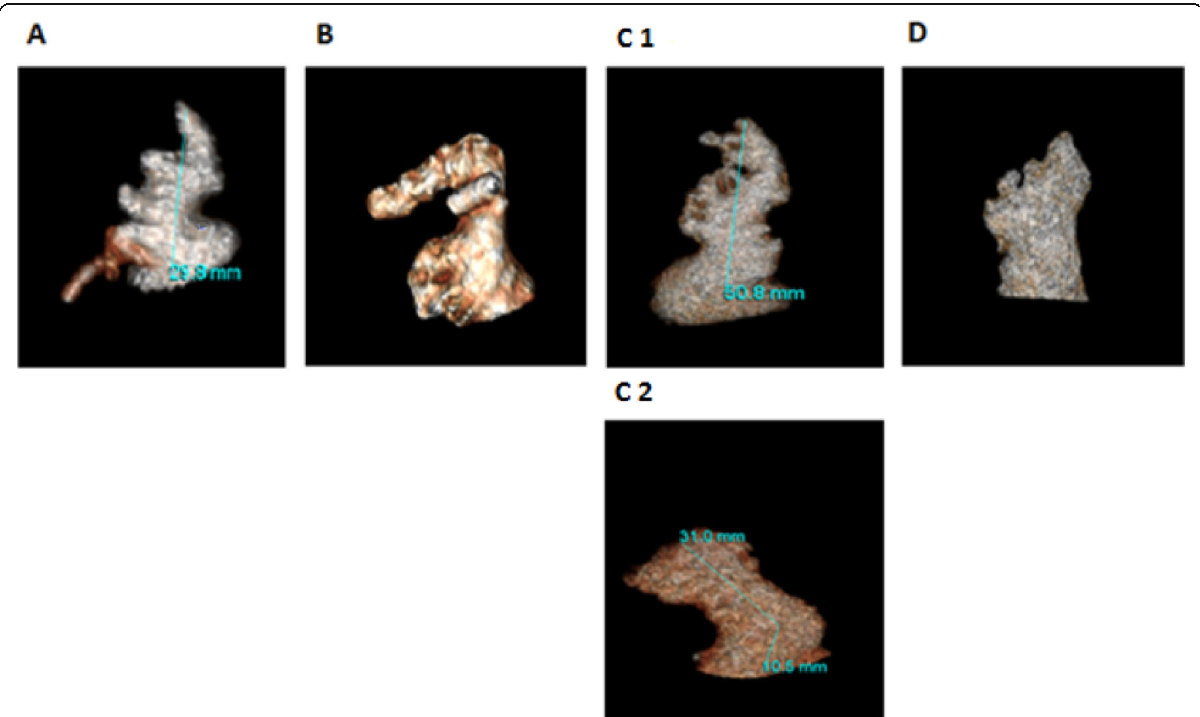
Fig. 1 The four different left atrial appendage morphologies in our three-dimensional reconstruction MDCT images: cactus ( a ), chicken wing ( b ), windsock ( c1 and c2 ), and cauliflower ( d